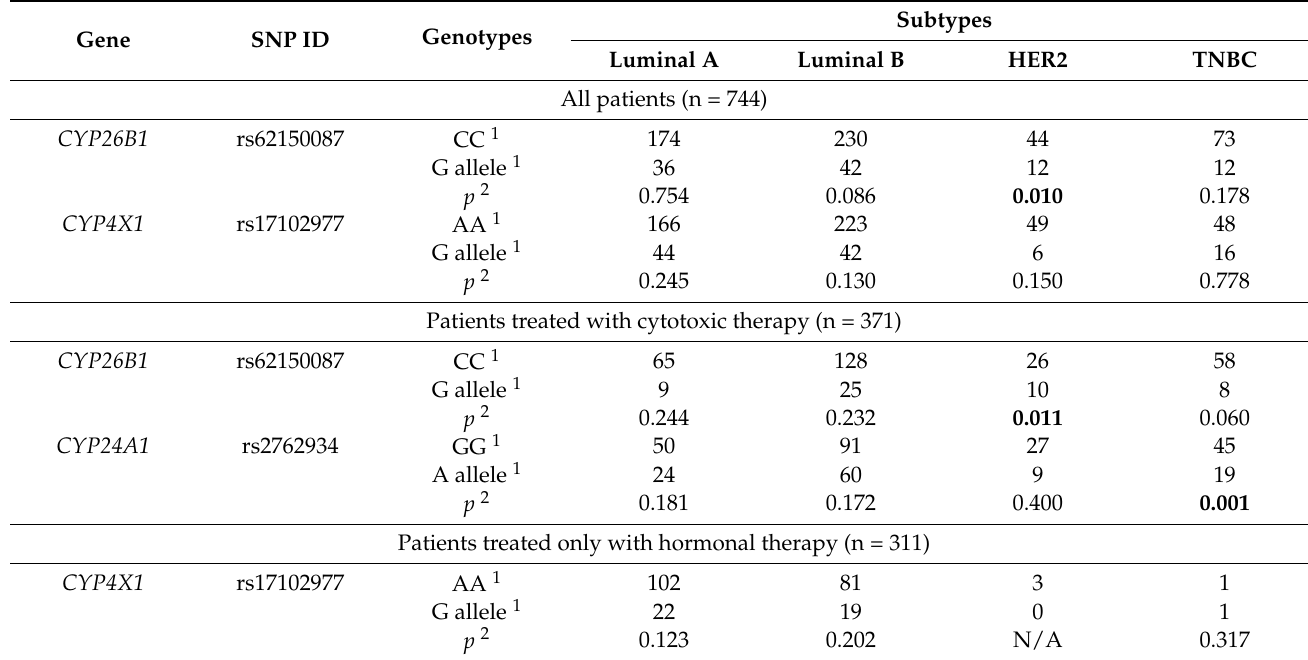
Table 5. The effect of breast cancer molecular subtypes on cytochrome P450 variants significantly associating with DFS of patients in the confirmation